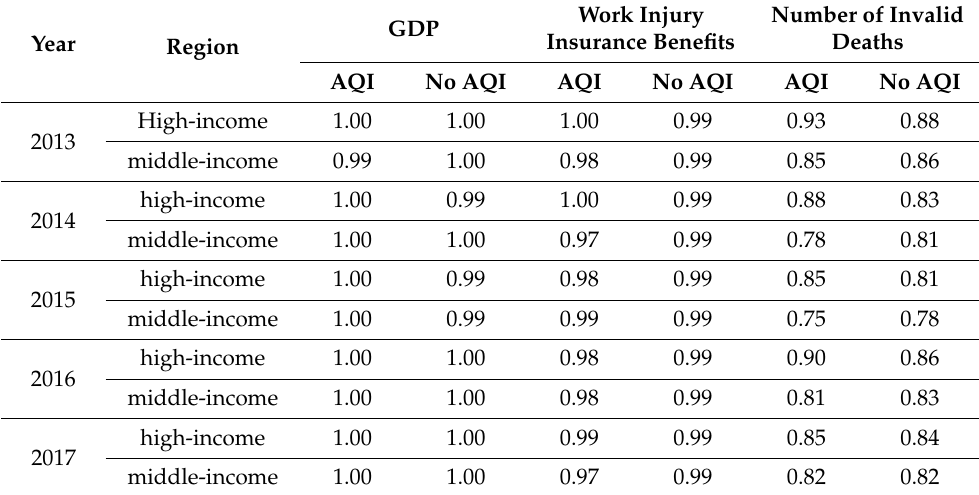
Table 4. Output variables from 2013–2017 between the high- and upper-middle-income regions. Year Region